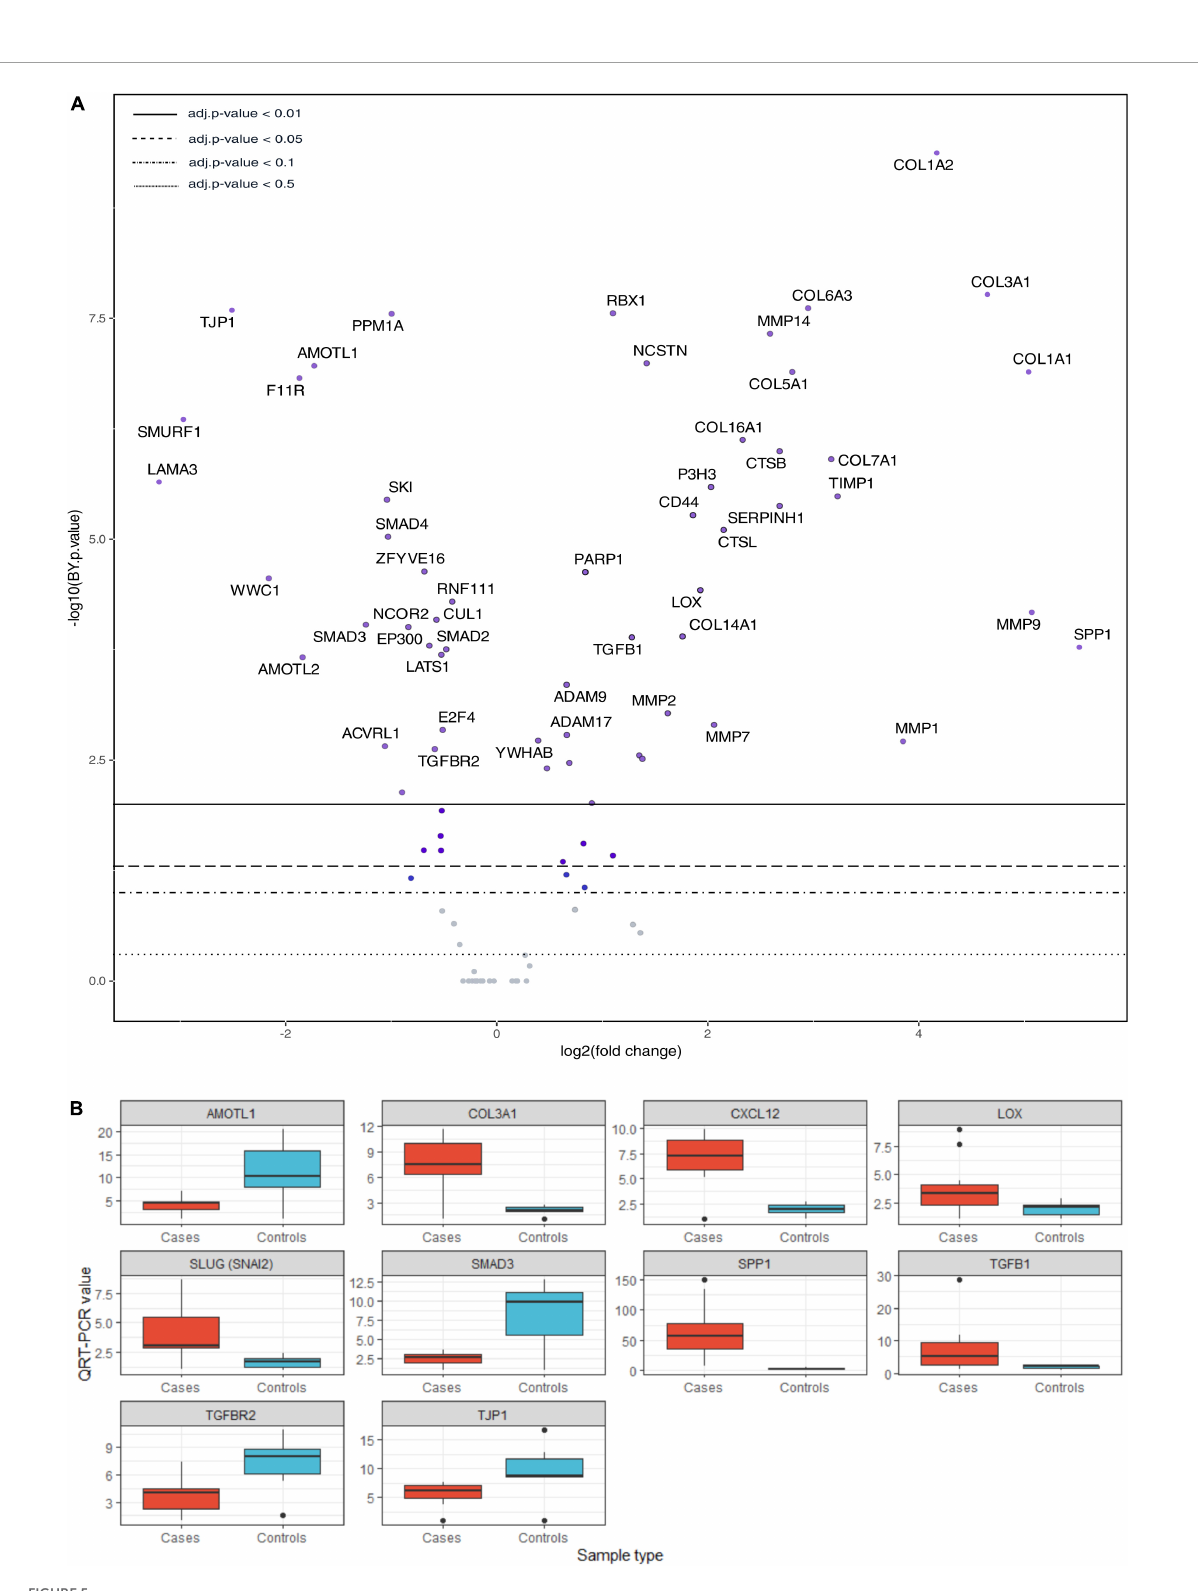
FIGURE5 (A) Volcano plot showing differentially expressed genes of collagen biosynthesis, extracellular matrix biosynthesis and degradation, TGF- β and Hippo pathways. (B) Validation by qRT-PCR. T -test: AMOTL1 p = 0.031, COL3A1 p = 0.00028, CXCL12 p = 3.9 e-05, LOX p = 0.027, SLUG (SNAI2) p = 0.0052, SMAD3 p = 0.014, SPP1 p = 0.00083, TGFB1 p = 0.043, TGFBR2 p = 0.029, TJP1 p = 0.072. QRT-PCR units: (cid:49)(cid:49)